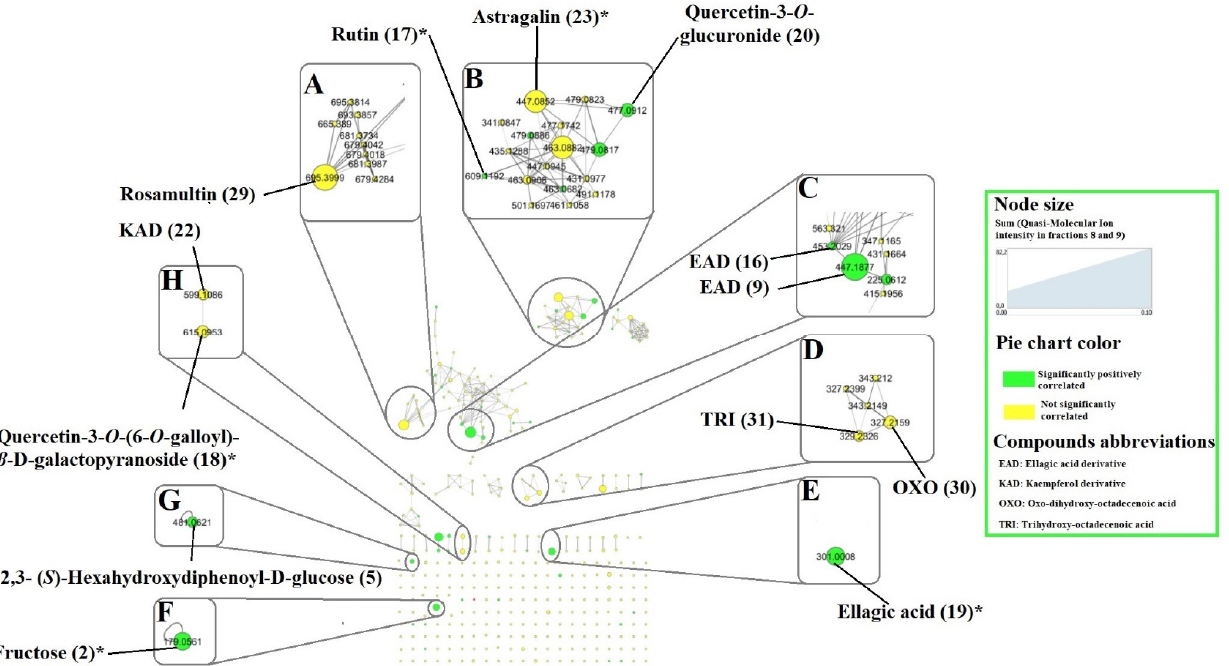
Figure 4. Molecular network of fractions of MeOH extract of Terminalia leiocarpa leaves showing compounds significantly positively (green nodes) or not significantly (yellow nodes) correlated with the anthelmintic activity on C. elegans . The numbers indicate the identification code of the compounds and asterisks show the compounds whose identification was confirmed by the injection of a standard. ( A ) triterpenic derivatives, ( B ) O -glycosylated flavonoids, ( C ) ellagic acid derivatives, ( D ) fatty acids, ( E ) ellagic acid, ( F ) sugar, ( G ) tannin, ( H ) glycosylated galloylated flavonoids. Edge widths are proportional to the level of similarity (cosine score). The size of the nodes is proportional to the sum of quasi-molecular ion intensity of fractions 8 and 9. * compounds identified by standard